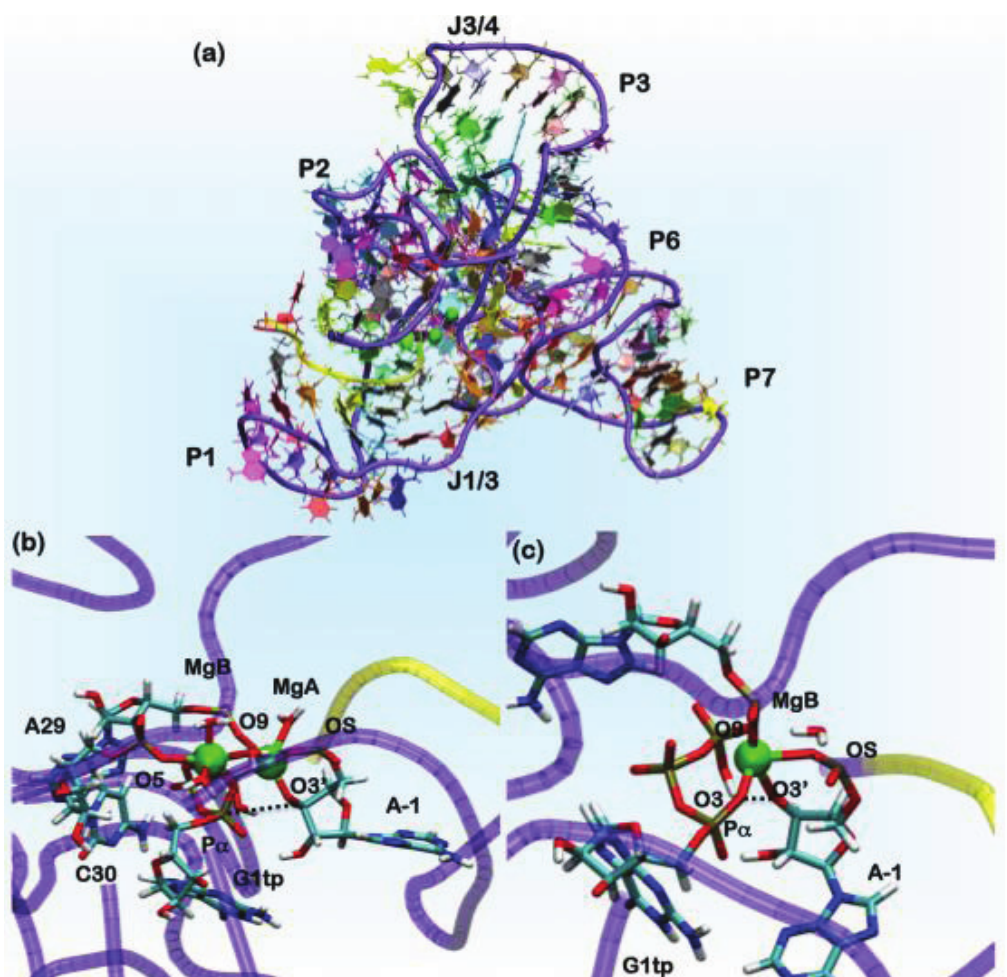
orientations. In green spheres, the position of the Mg(II) ions is shown. In the yellow tube, the U-7-A-1 tract of the ribozyme is shown, which performs the nucleophilic attack on the P α of the G1tp base. The rest of the ribozyme is shown as a violet tube. Nucleobases are colored by residue types. Representative structures of AdMgAB and AdMgB were obtained from QM/MM MD simulations, in ( b ) and ( c ), respectively. The ribozyme is represented in tube form following the same scheme mentioned above, while residues forming the binding site are shown in licorice and colored by the atom